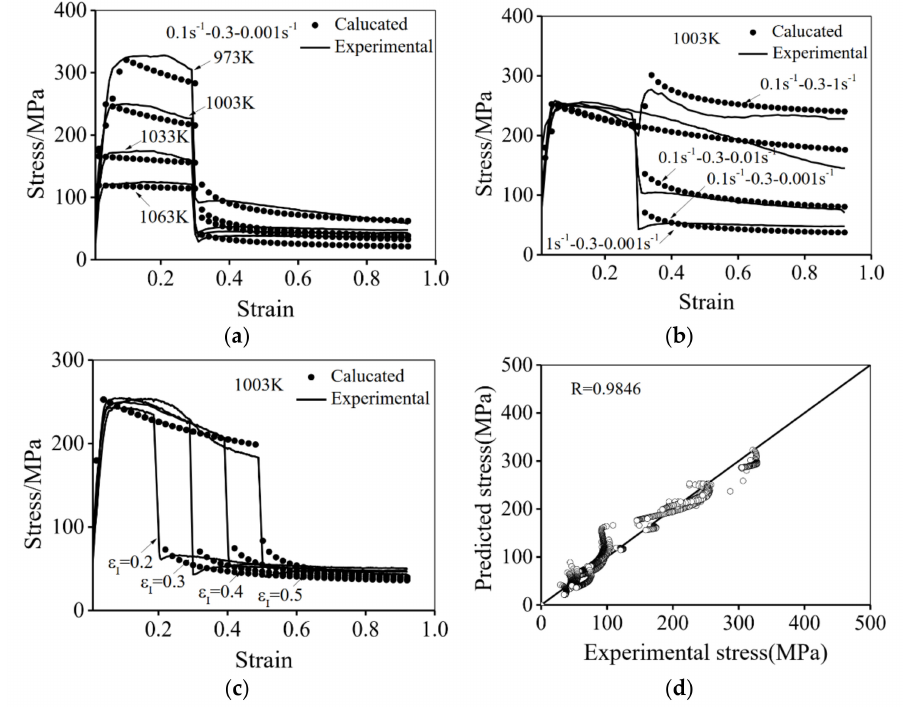
Figure 10. Comparisons of the calculated (solid line) and experimental (symbol) strain-stress curves . ε 2 ; ( c ) ε I ; ( d ) correlation at different: ( a ) temperatures; ( b )